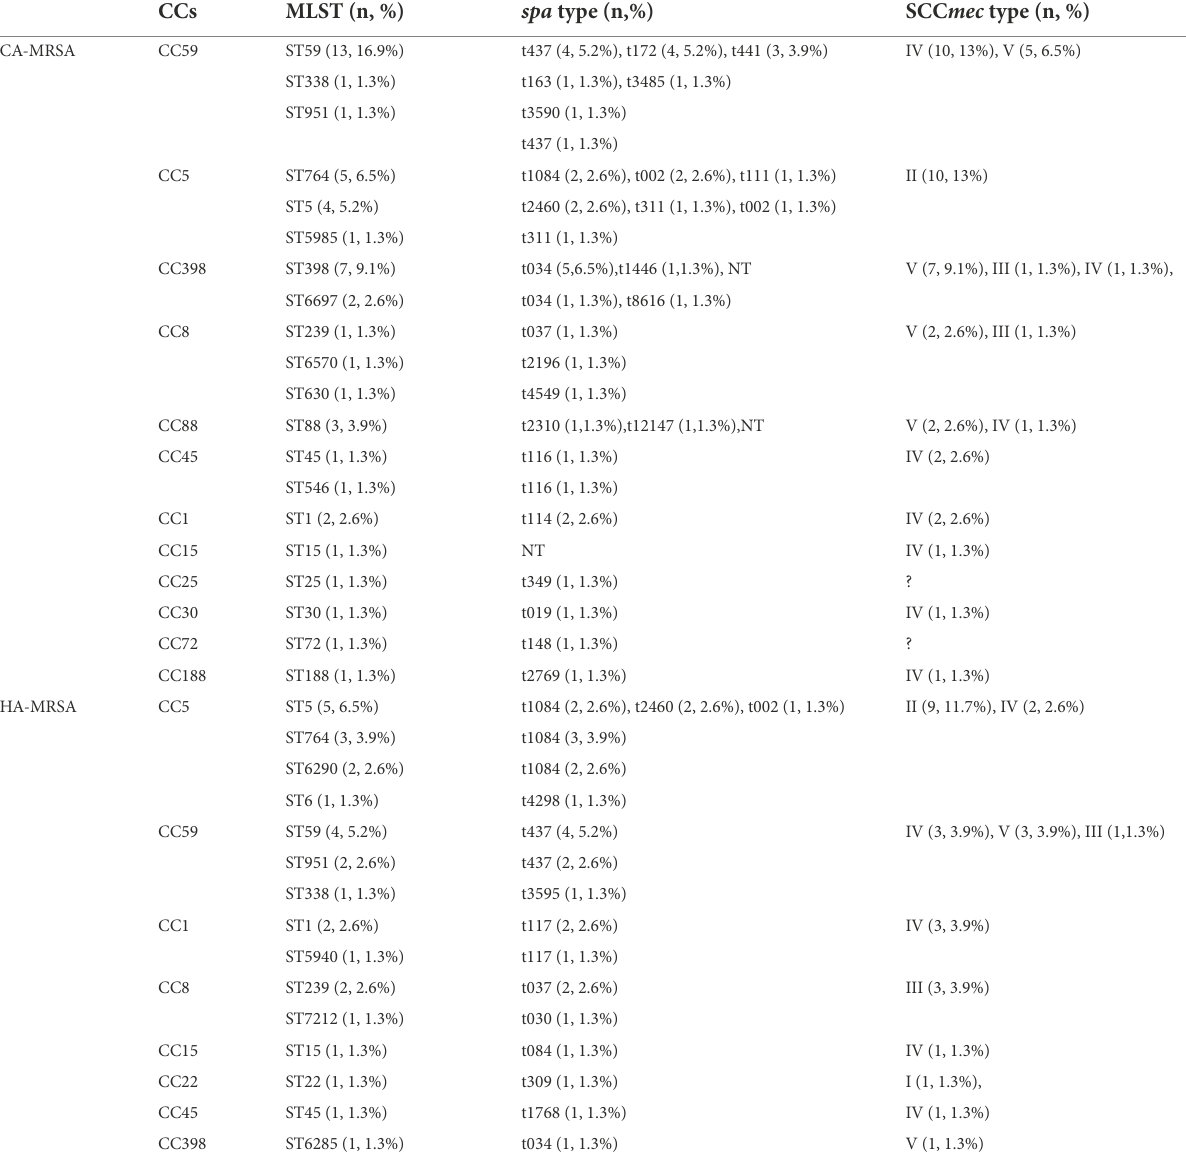
TABLE 4 Molecular characteristics of 77 community-acquired MRSA (CA-MRSA) and hospital-associated MRSA (HA-MRSA)